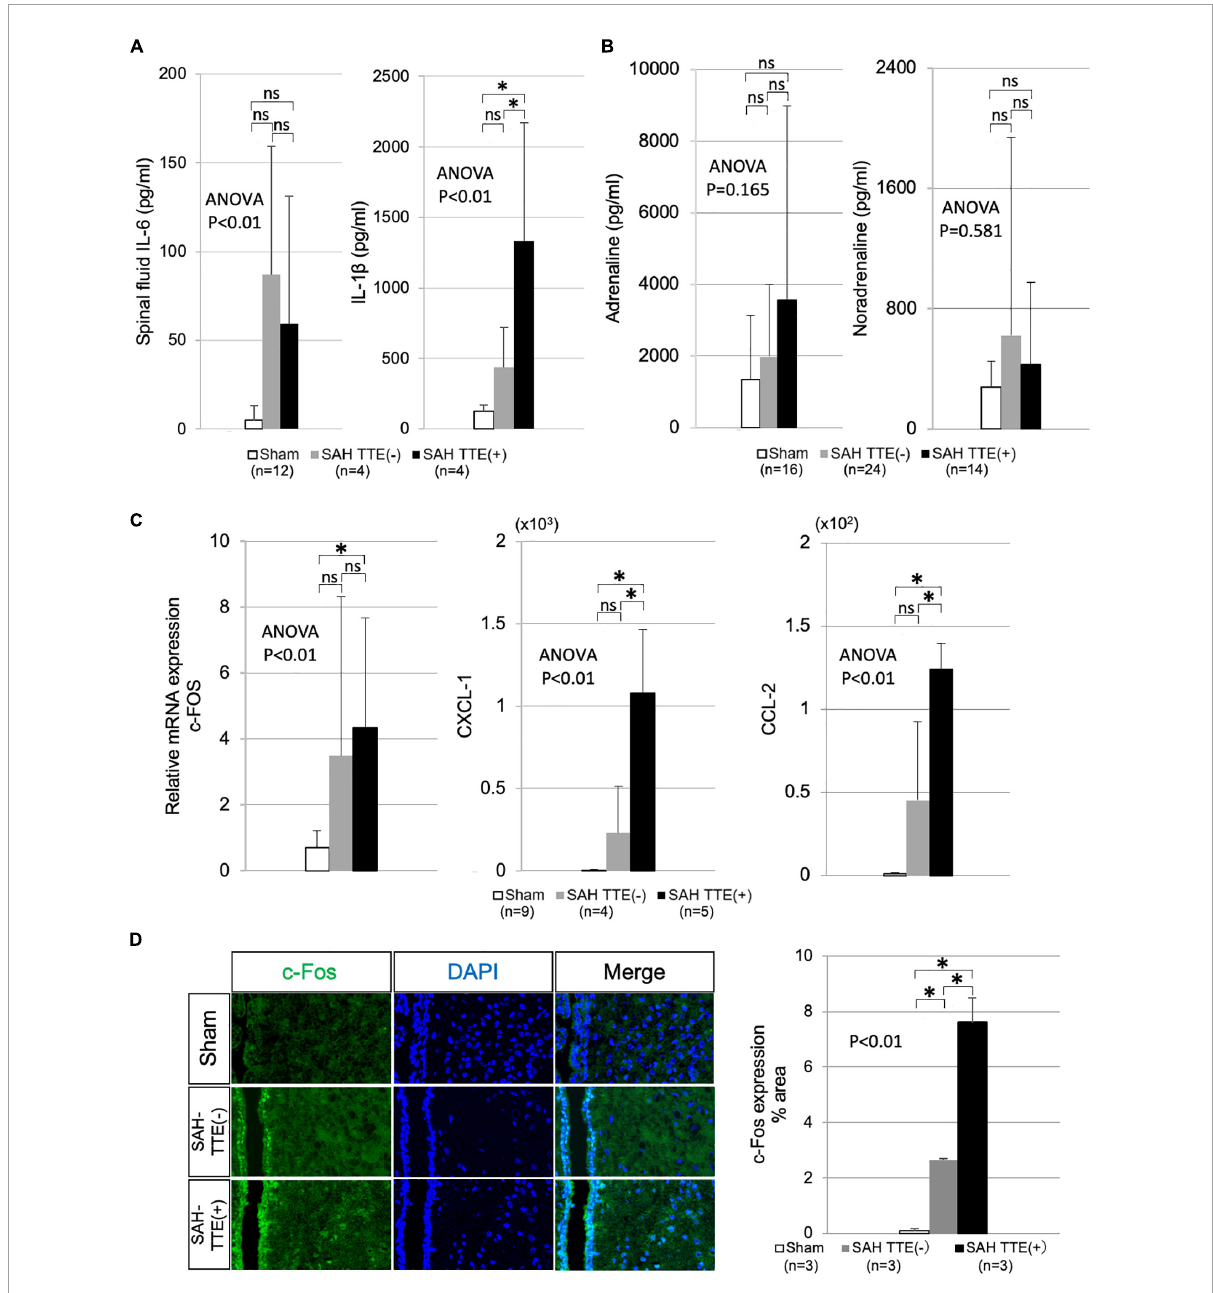
FIGURE3 CSF, blood, and brain analyses in the SAH and sham groups. (A) Concentration of IL-6 and IL-1 β in the CSF of the sham ( N = 12), SAH TTE ( − ; N = 4), and SAH TTE (+; N = 4) groups. (B) Blood adrenaline and noradrenaline levels of the sham ( N = 16), SAH TTE ( − ; N = 24), and SAH TTE (+; N = 14) groups. (C) mRNA expression of c-Fos, CXCL-1, and CCL-2 in the PVN of the sham ( N = 9), SAH TTE ( − ; N = 4), and SAH TTE (+; N = 5) groups. (D) Immunostaining for c-Fos near the PVN and third brain ventricle in the sham ( N = 3), SAH TTE ( − ; N = 3), and SAH TTE (+; N = 3) groups. CCL-2, chemokine (C-C motif) ligand 2; CXCL-1, chemokine (C-X-C motif) ligand 1 (CXCL-1); CSF, cerebrospinal fluid; IL, interleukin; PVN, paraventricular hypothalamic nucleus; and SAH, subarachnoid hemorrhage. *Indicated P <